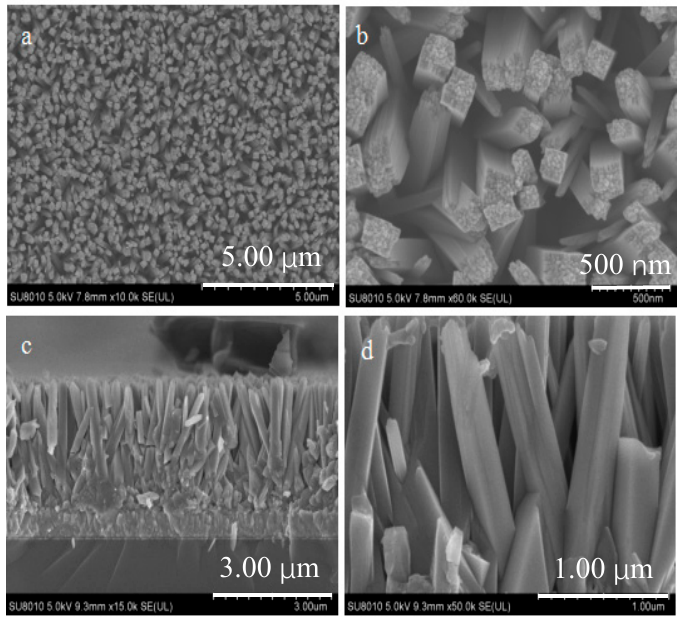
Figure 2. Scanning electron microscopy (SEM) images of as-prepared TiO 2 photoanode. The micro scale ( a ) and nano scale ( b ) top view, cross-sectional view ( c ), and partially enlarged cross-sectional view ( d ).